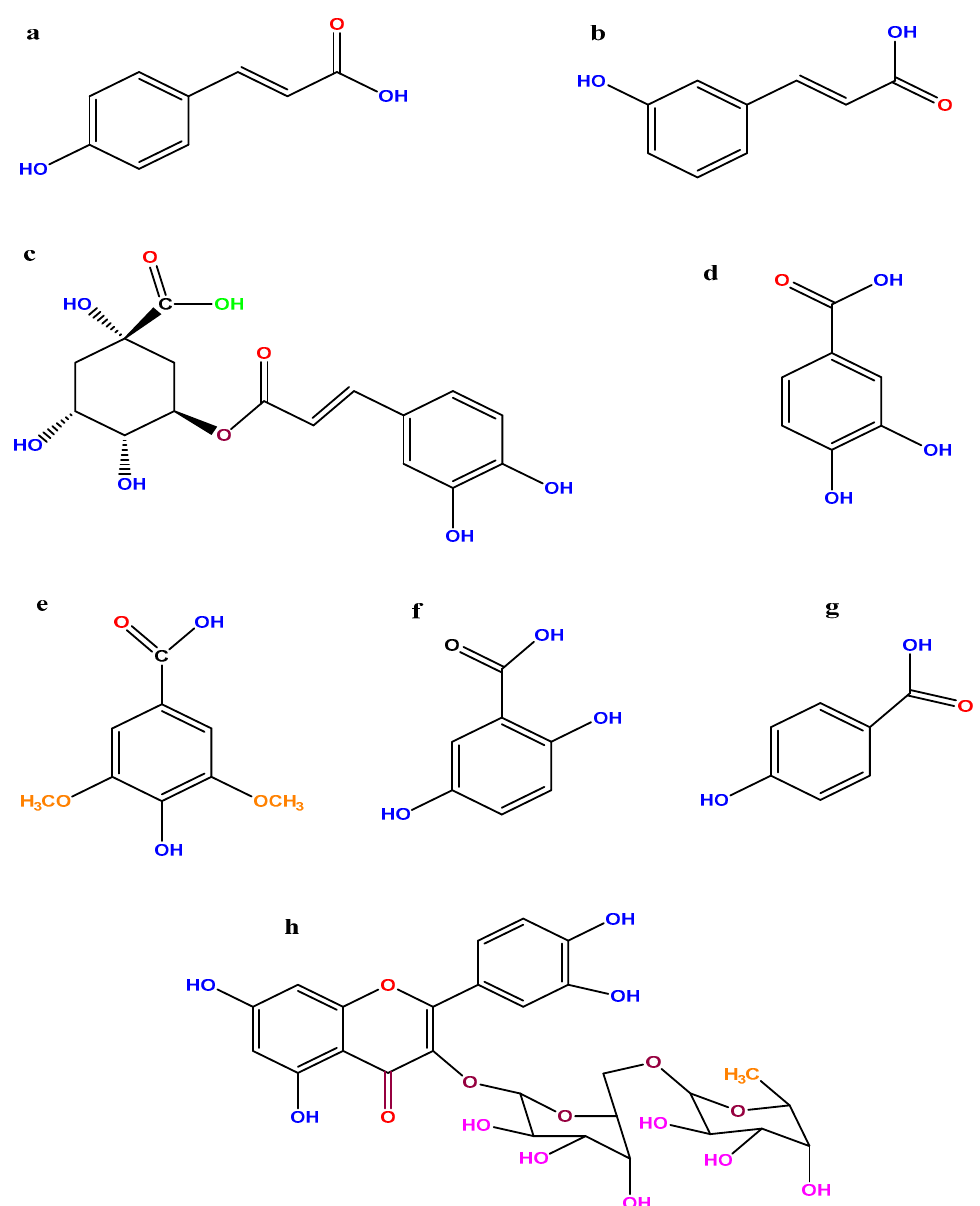
Figure 1. Chemical structure of major phenolic compounds in P. ginseng extract: ( a ) p -coumaric acid; ( b ) m -coumaric acid; ( c ) chlorogenic acid; ( d ) protocatechuic acid; ( e ) syringic acid; ( f ) gentisic acid; ( g ) p -hydroxybenzoic acid; and ( h )